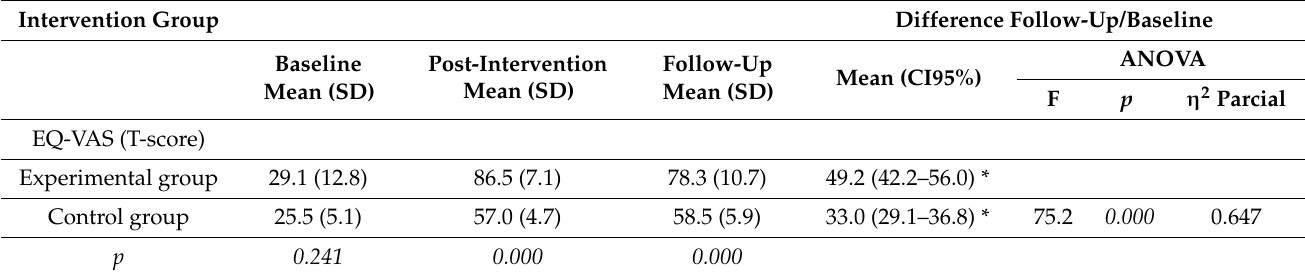
Table 2. Linear model. Effect of the intervention on EuroQoL visual analog scale (EQ-VAS)